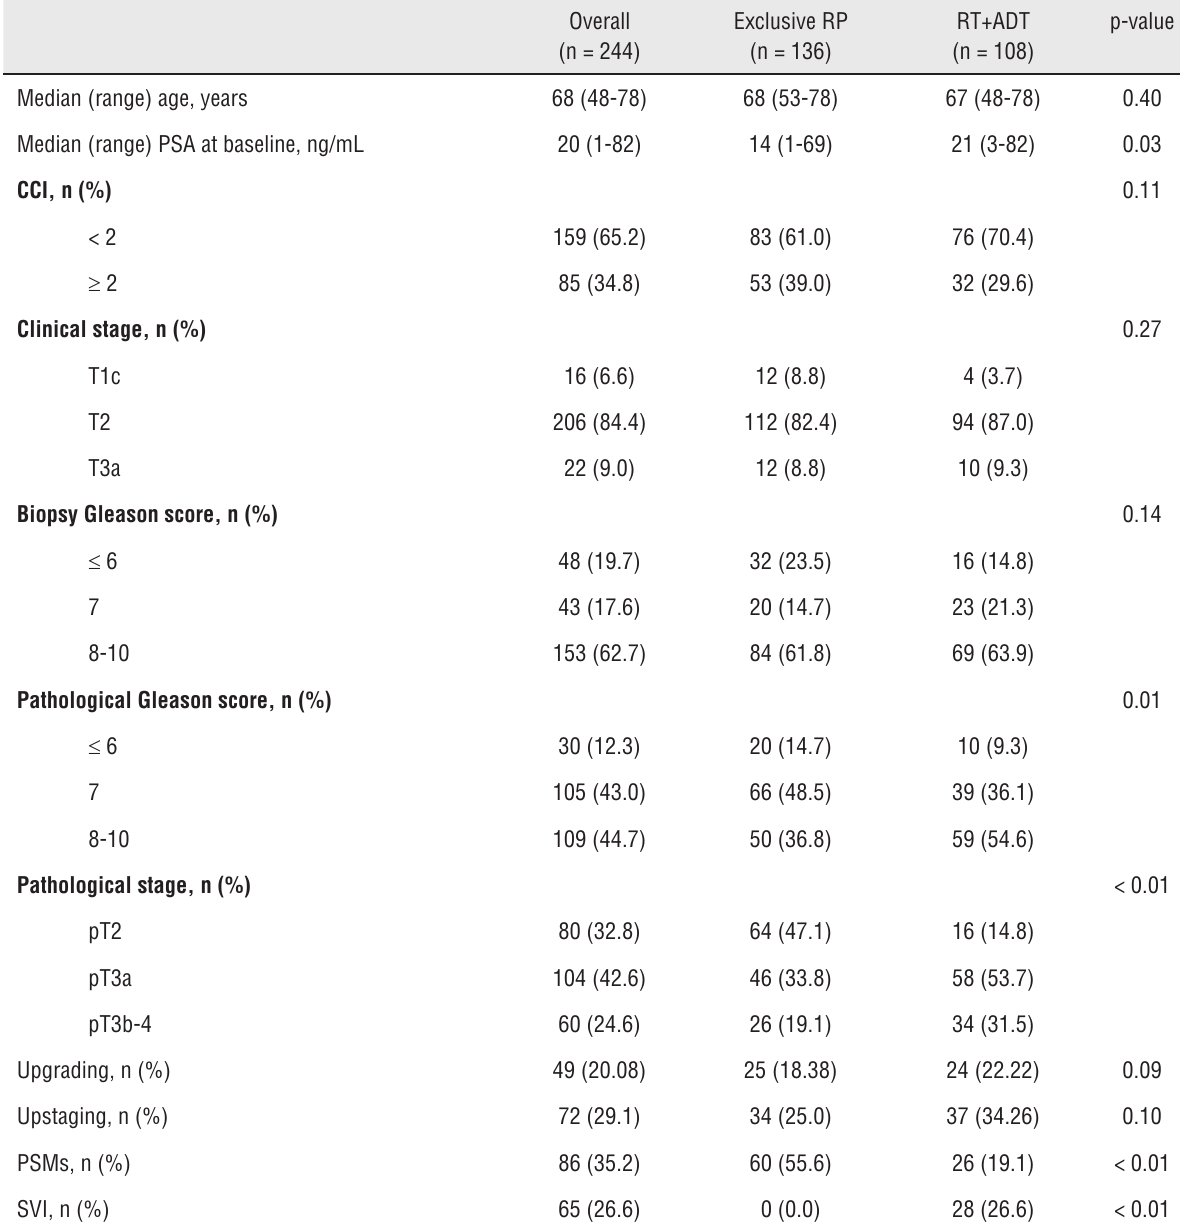
Table 1 - Clinical and pathological characteristics of patients.